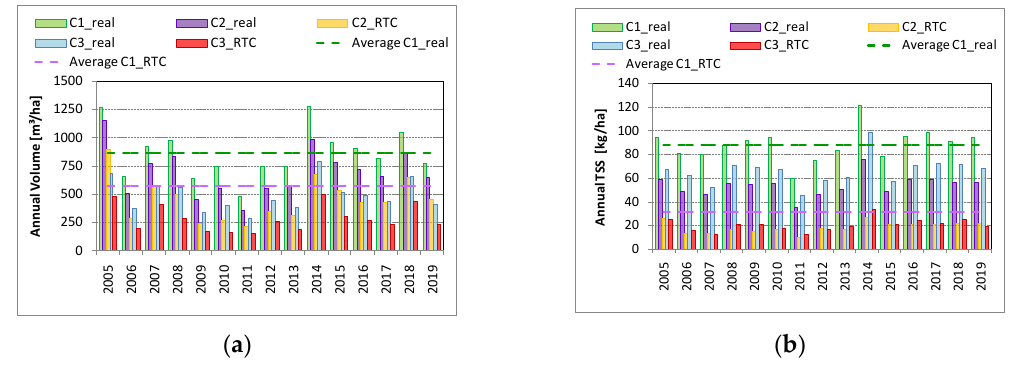
Figure 12. Graphs related to the annual volume ( a ) and TSS ( b ) sent to the receiver when comparing the real scenario C.1 real with scenarios C2 and C3 with and without the RTC system.